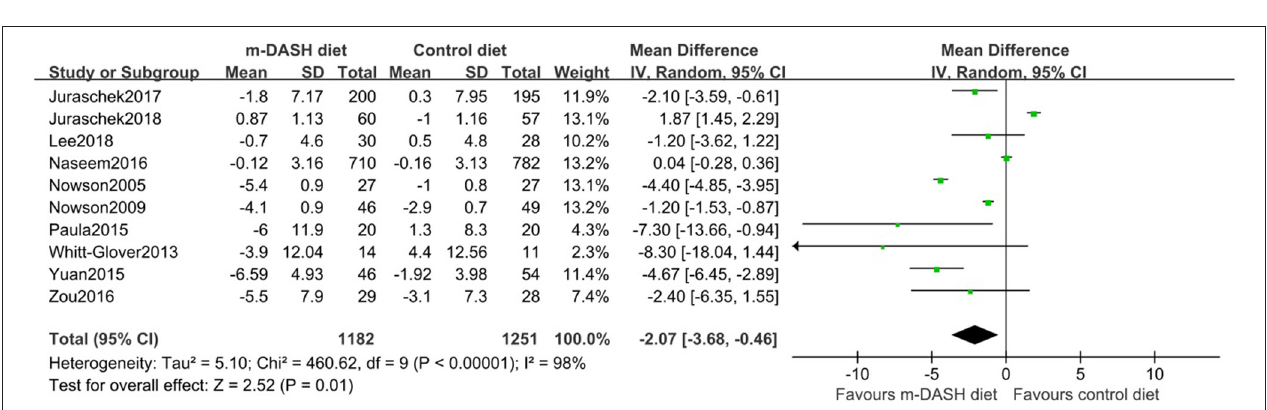
FIGURE 4 | Forest plots of randomized controlled trials investigating the effects of the modified Dietary Approaches to Stop Hypertension (DASH) on diastolic blood pressure (DBP).